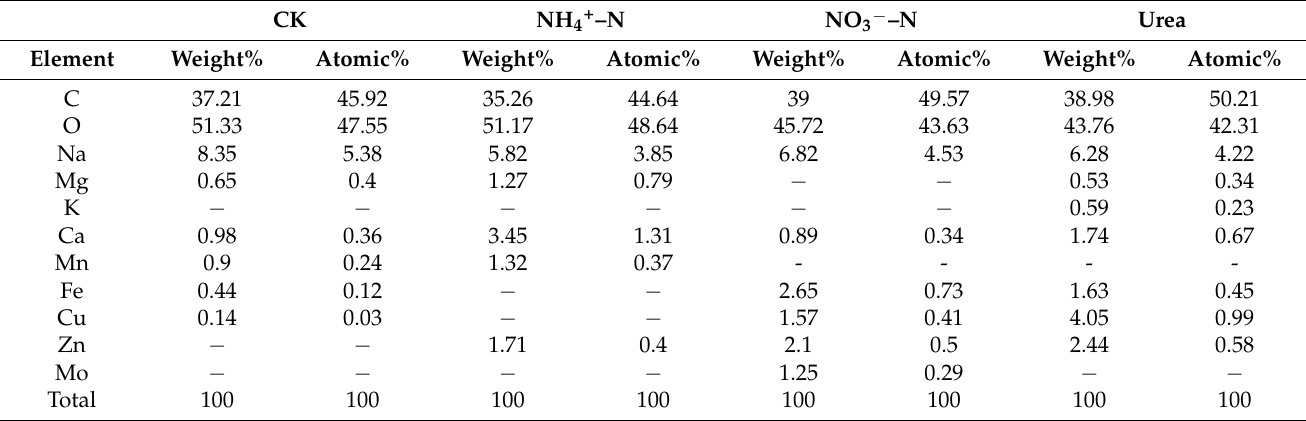
Table 1. Quantitative analysis results obtained by EDS with different N treatments.